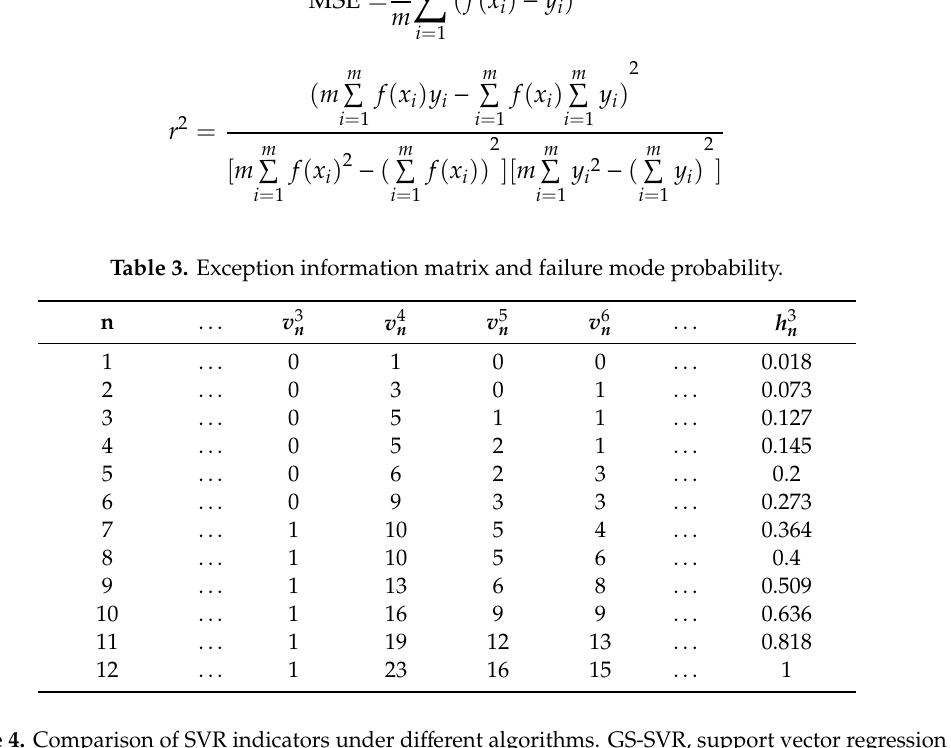
Table 4. Comparison of SVR indicators under di ff erent algorithms. GS-SVR, support vector regression